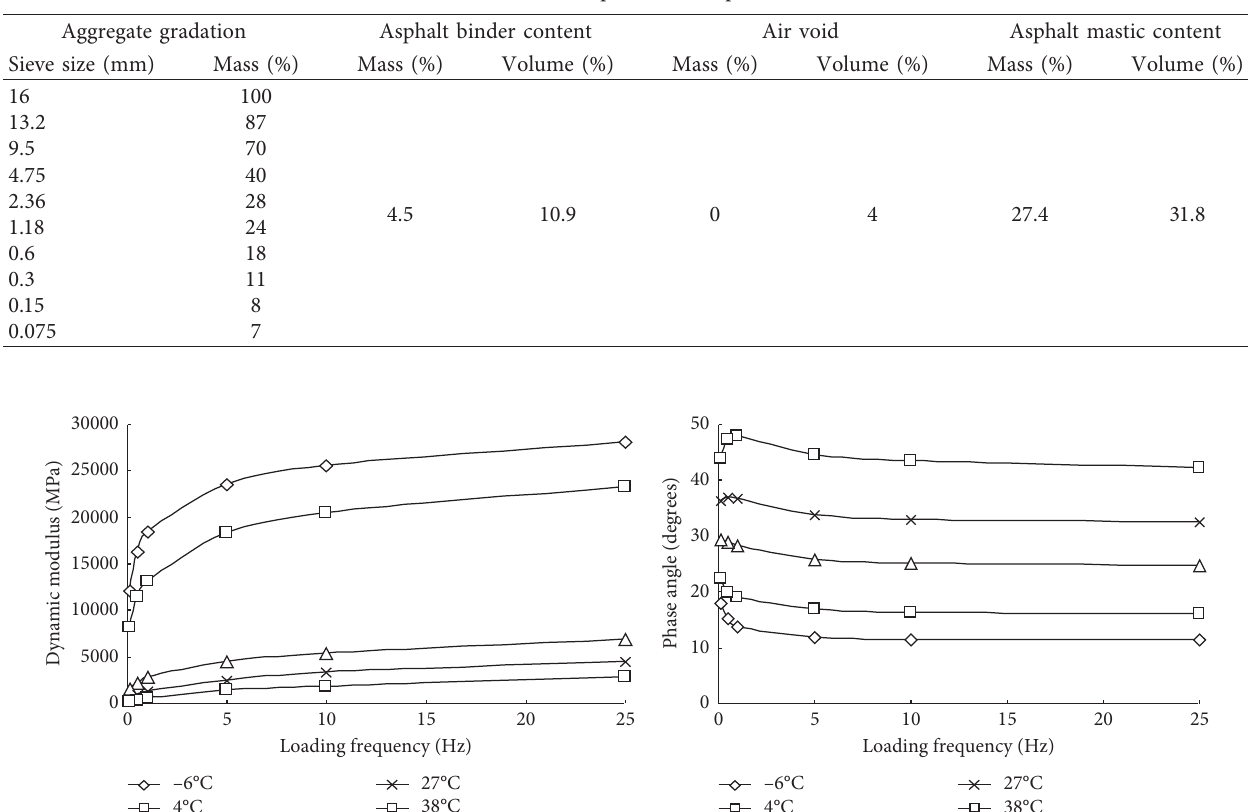
Table 5: Material composition of asphalt concrete.